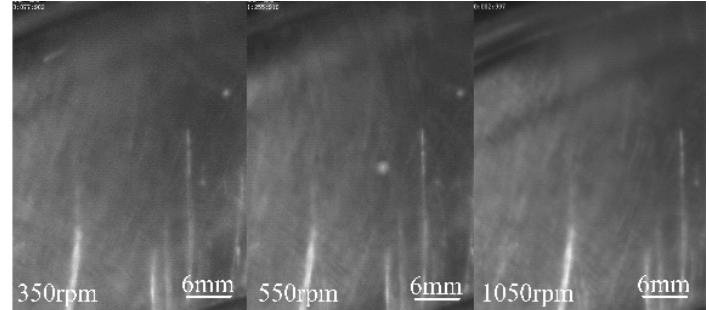
Figure 23. Cavitation morphology of oil film without texture.